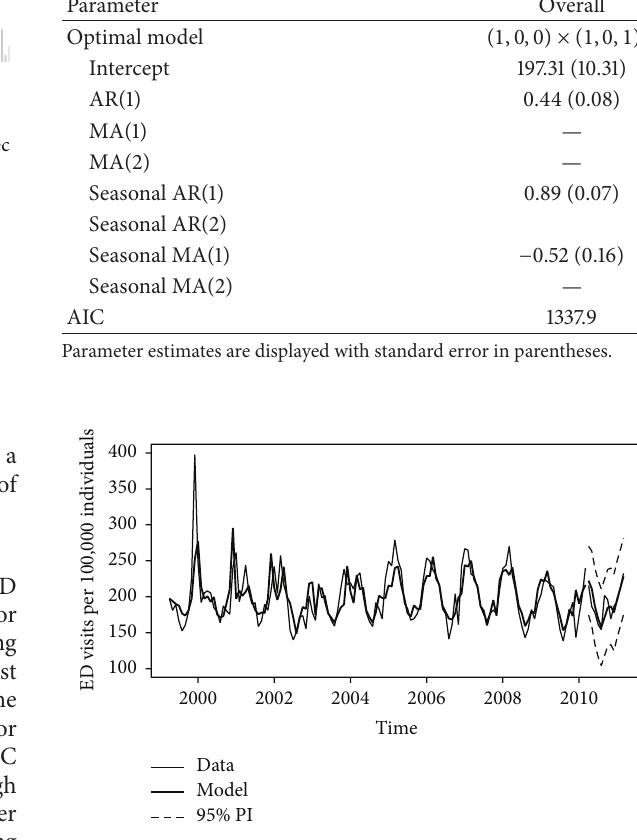
Table 2: Overall optimal model and parameter estimates for COPD ED visit rates.